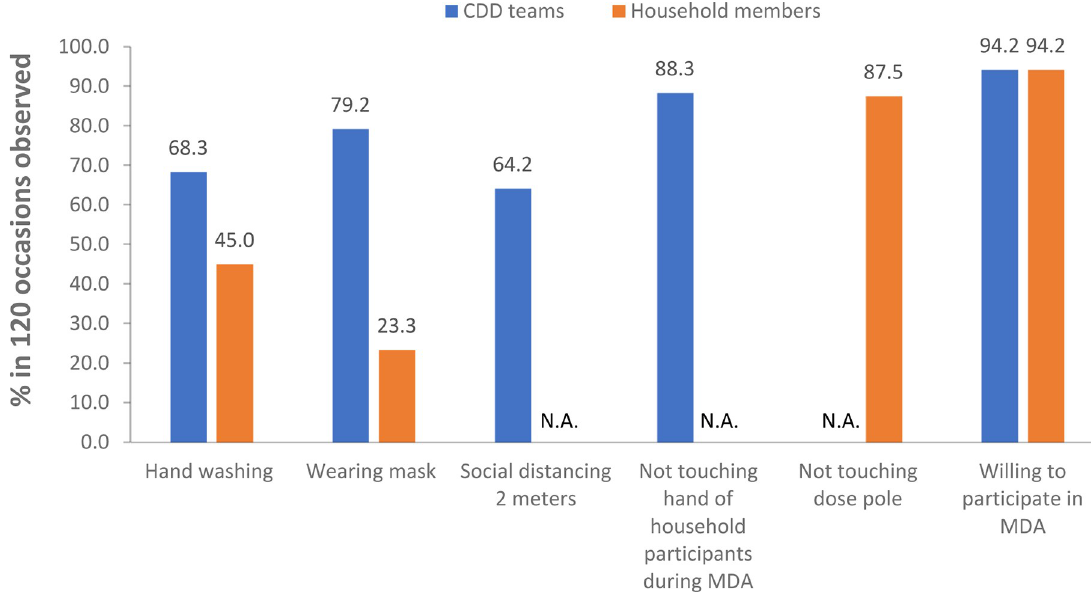
Fig 1. Adherence to COVID-19 preventive and barrier measures by the CDD teams and household participants during MDA in 14 health districts in 2020 in Guinea.